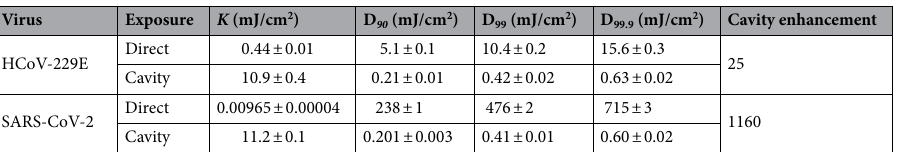
Table 1. Linear regression parameters from fitting of the survival curves for the direct pulsed UVC laser and LICD cavity exposures of the HCoV-229E and SARS-CoV-2. Cavity enhancement factors show the increase of the inactivation efficiency of the LICD compared to the direct